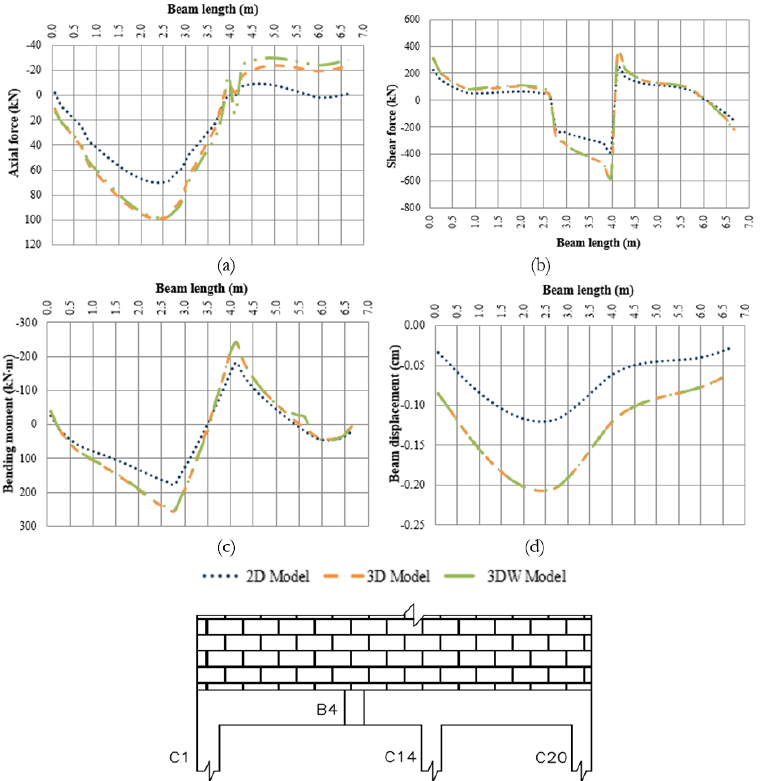
Figure 10. Forces on the support beam of Wall 30: (a) Axial force; (b) Shear force; (c) Bending moment; (d) Vertical displacement.